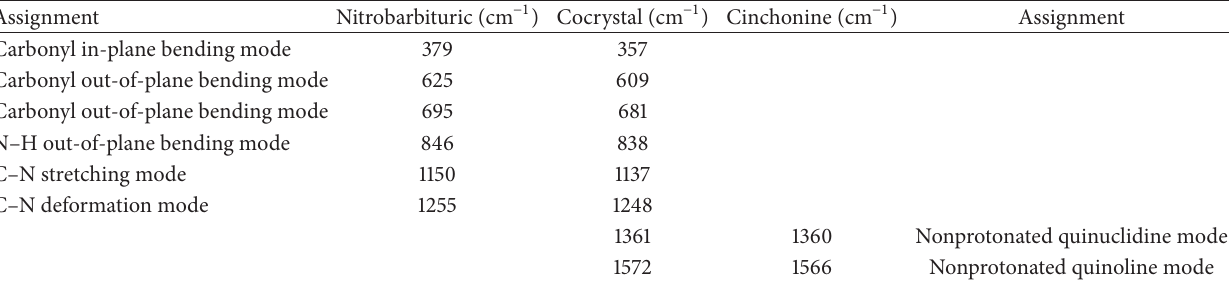
Table 2: Assignments of the major bands in the fingerprint region of the Raman spectra of 5-nitrobarbituric acid, cinchonine, and their 1:1 cocrystal product.